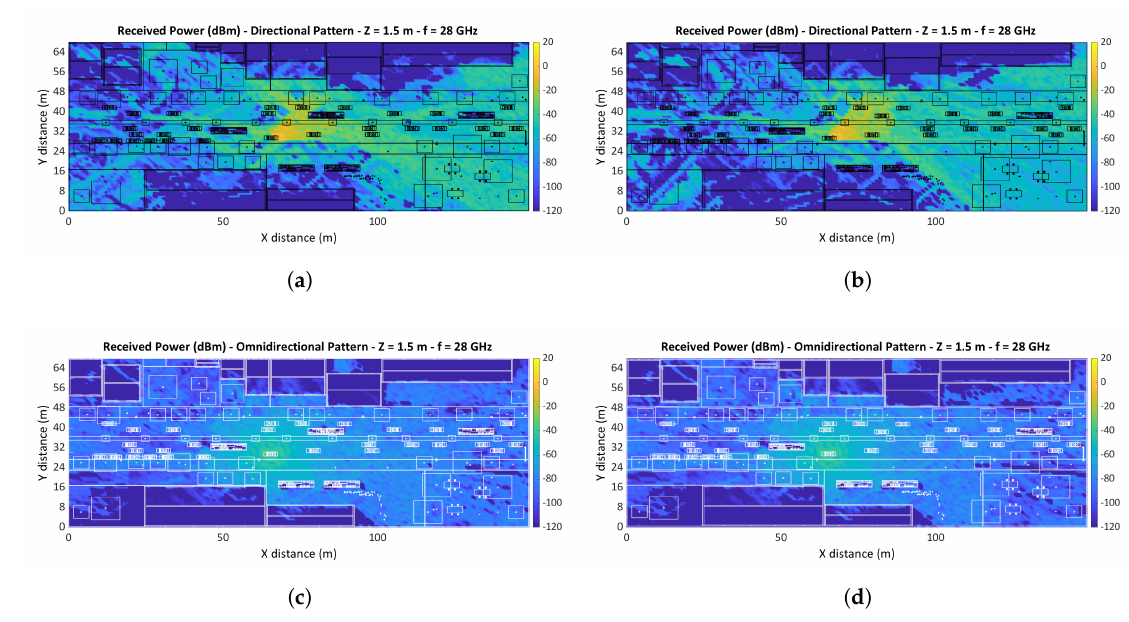
Figure 10. Received power (dBm) at 1.5 m height: ( a ) Directional radiation antenna pattern and bus obstruction, ( b ) Directional radiation antenna pattern and car obstruction, ( c ) Omnidirectional radiation antenna pattern and bus obstruction, ( d ) Omnidirectional radiation antenna pattern and car